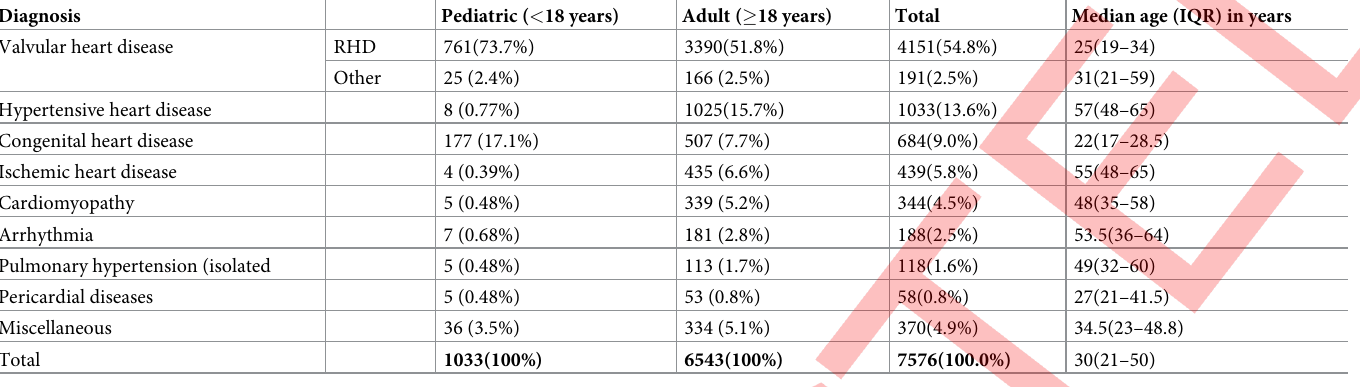
Table 2. Distribution of different cardiovascular diagnosis among pediatric and adult patients with their corresponding median age, 2015–2018,